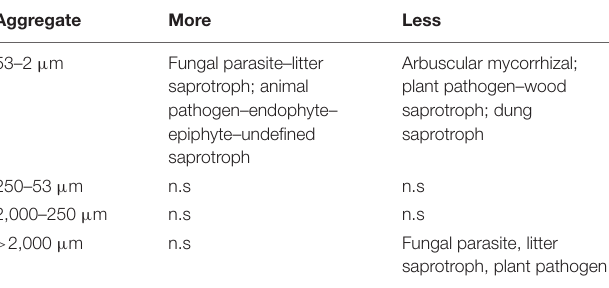
TABLE 6 | Summary of the FUNGuild results of ITS1 among size fractions.